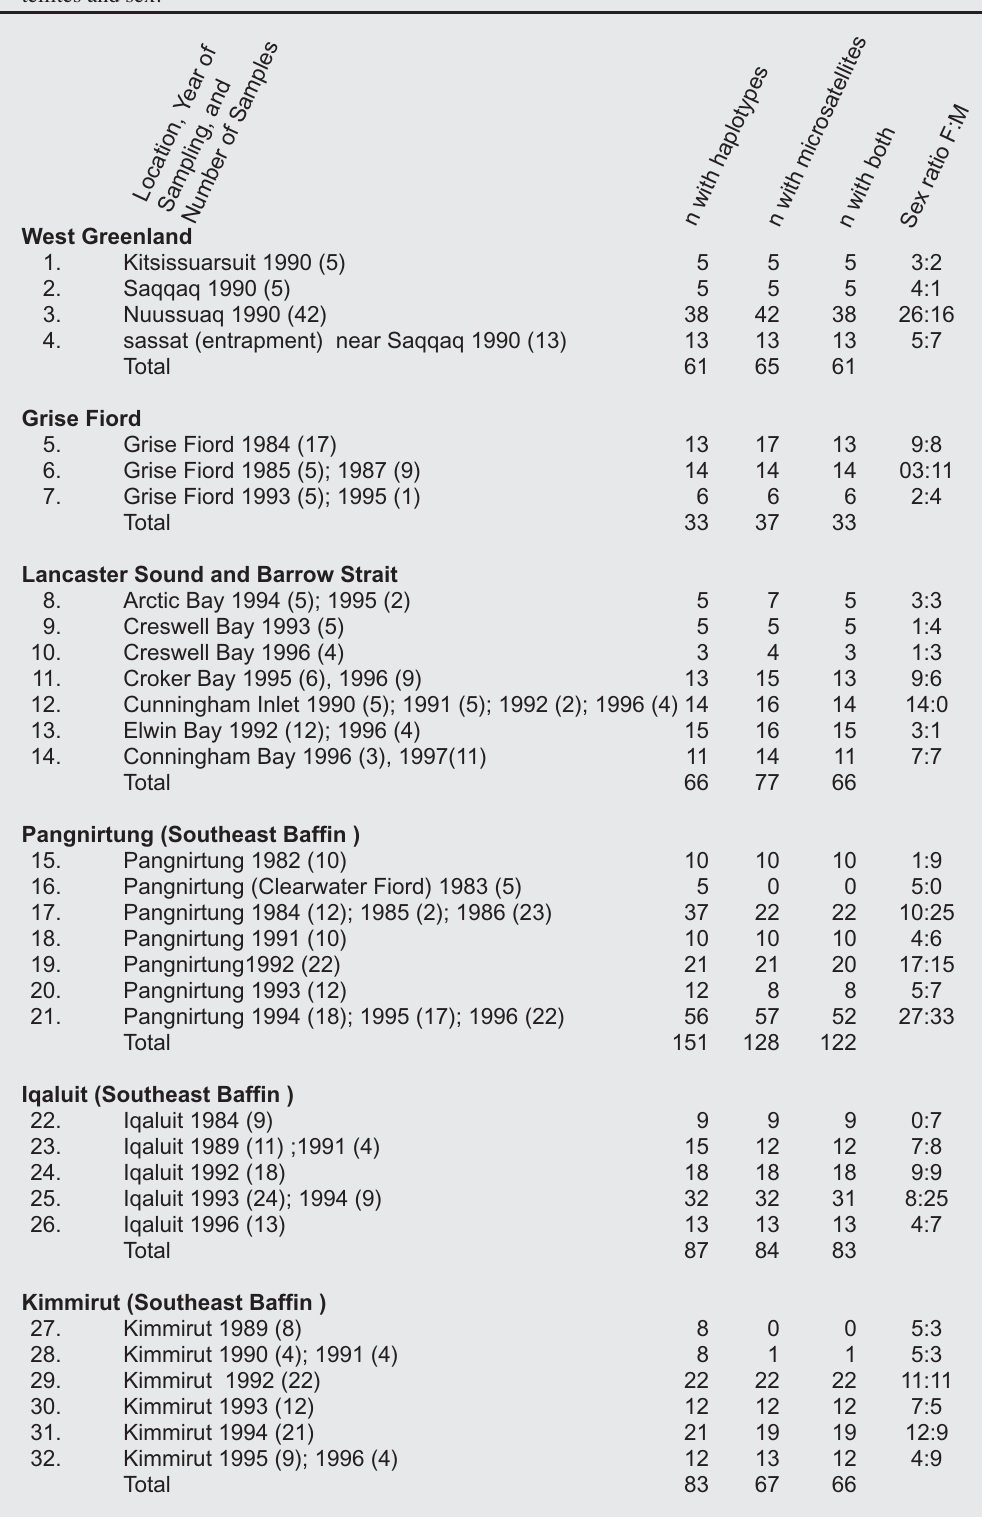
Table 1 . Beluga collections. List of beluga samples split by locality, year, mtDNA haplotypes, microsa- tellites and